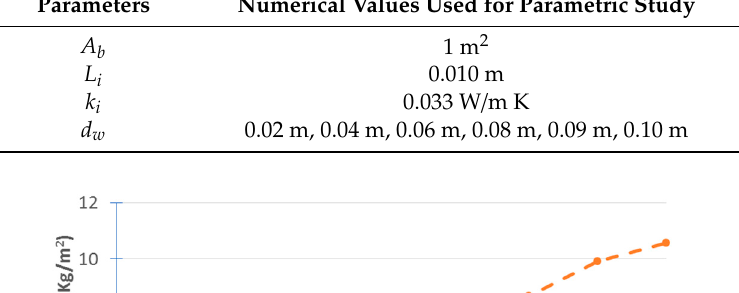
Table 7. Modified still parameters used for parametric study.